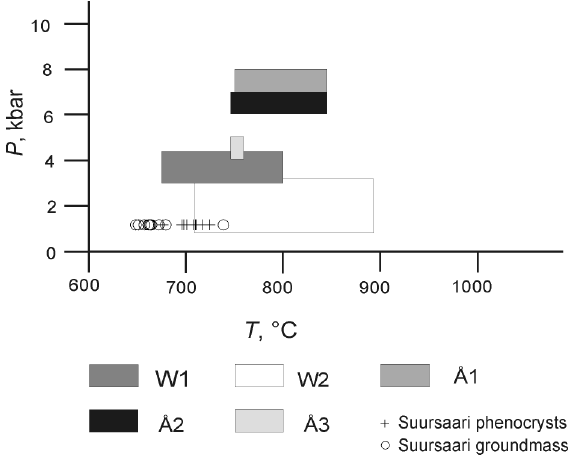
Fig. 7. Suursaari rapakivi intrusion P (cid:150) T conditions in comparison with previously published data on other rapakivi intrusions in the southern slope of the Fennoscandian Shield (for legend references see Table 1).